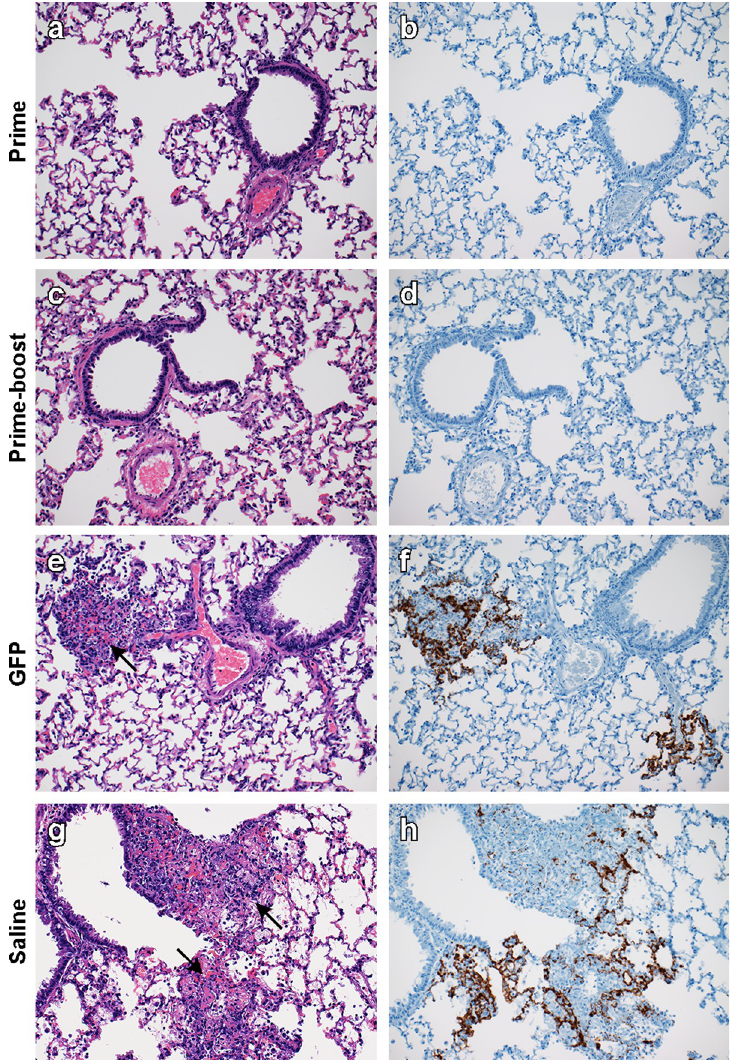
Fig 2. Single-dose vaccination with ChAdOx1 NiV B protects Syrian hamsters against bronchointerstitial pneumonia caused by NiV Bangladesh challenge. Hamsters were vaccinated with ChAdOx1 NiV B or injected with ChAdOx1 FGP or saline and challenged with NiV Bangladesh. Lung tissue was collected at D5. Tissue sections were stained with hematoxylin-eosin (left panels) or with target-specific probes for NiV RNA, which is visible as a red- brown staining (right panels). (a-b) Lung tissue obtained at D5 of animals vaccinated with a single-dose of ChAdOx1 NiV B . (c-d) Lung tissue obtained at D5 of animals vaccinated with a prime-boost regime of ChAdOx1 NiV B . (e-f) Lung tissue obtained at D5 of animals injected with a prime-boost regime of ChAdOx1 FGP. (g-h) Lung tissue obtained at D5 of animals injected with saline. Arrow = Inflammatory cells, fibrin, edema and hemorrhage centered on terminal bronchioles. 200x magnification. H&E and ISH slides were from sequential